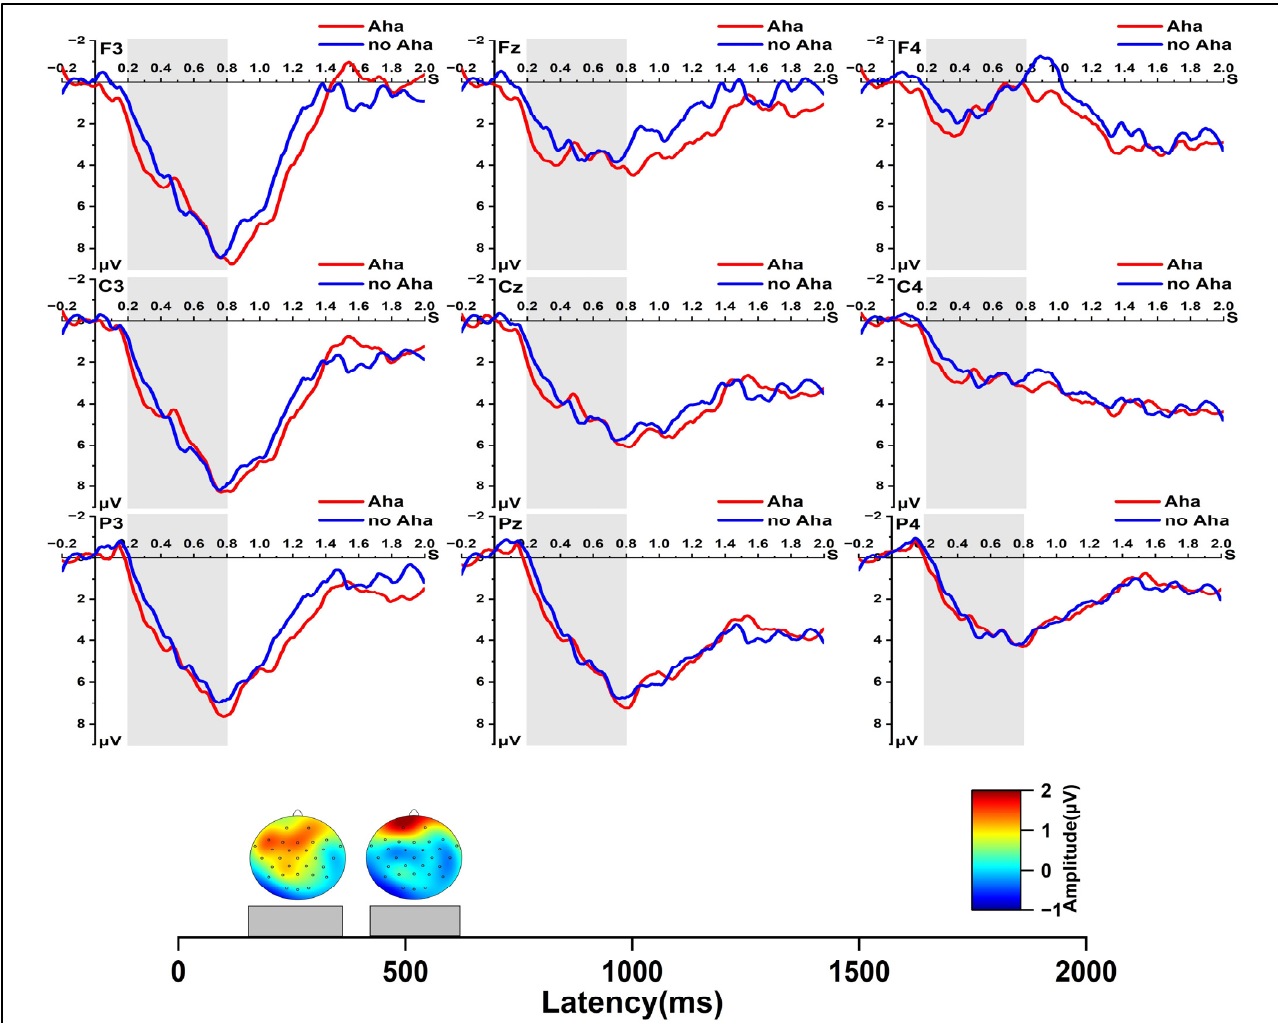
Figure 5. Grand-average ERPs from all selected channels for Aha and no Aha conditions and spherical-spline interpolated scalp distributions of the solution type (Aha minus no Aha) in 250~350 m and 400~500 ms time windows.